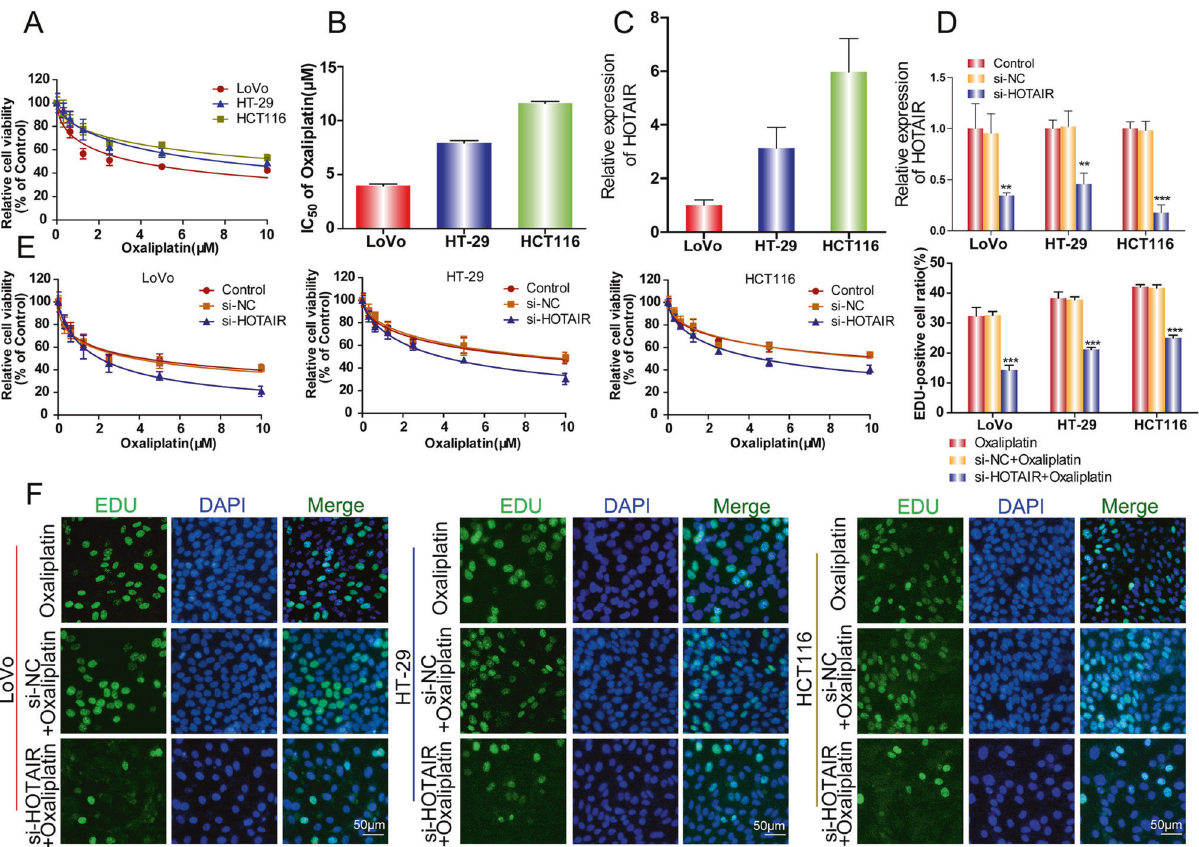
Fig. 2 Deletion of HOTAIR sensitized CRC cells to oxaliplatin. A , B The relative cell viability of CRC cells was detected by CCK-8 assay and the value of IC50 was shown. C HOTAIR expression level was detected in CRC cells by qRT-PCR. D qRT-PCR was used to detect the expression of HOTAIR after si-HOTAIR treatment. E CCK-8 was used to detect cell viability after si-HOTAIR treatment and exposure to oxaliplatin. F EdU was used to detect cell proliferation after si-HOTAIR treatment and exposure to oxaliplatin. * p < 0.05, ** p <